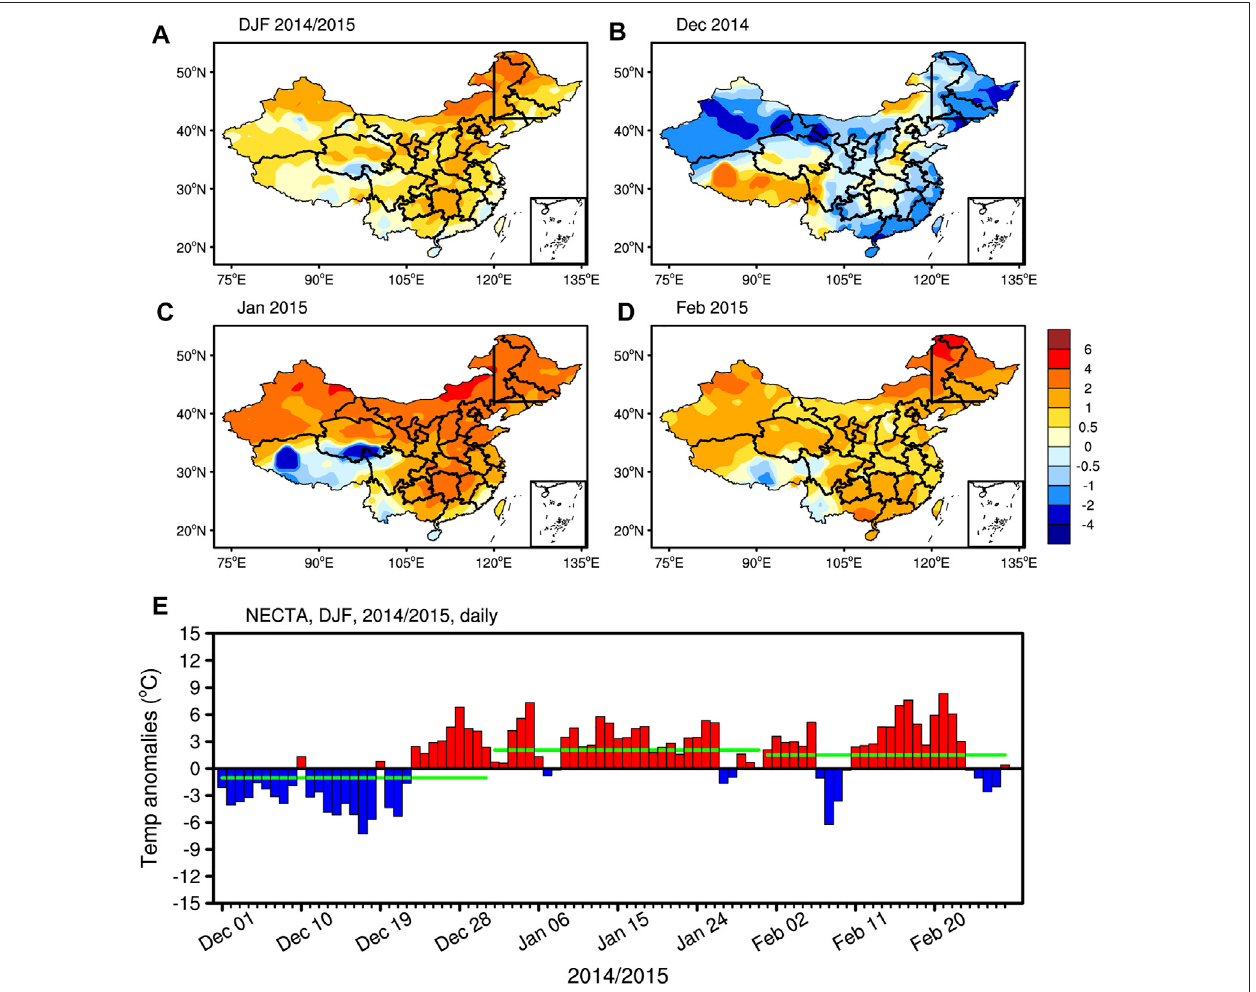
FIGURE 1 | Spatial pattern of (A) seasonally averaged and (B – D) monthly temperature (unit: ° C) over China in winter 2014/2015. (E) Time series of daily temperature anomalies over NEC inwinter 2014/2015. The black boxesin (A – D) denote thedomain ofNEC, and green lines in (E) indicate the monthlyaveraged values of temperature